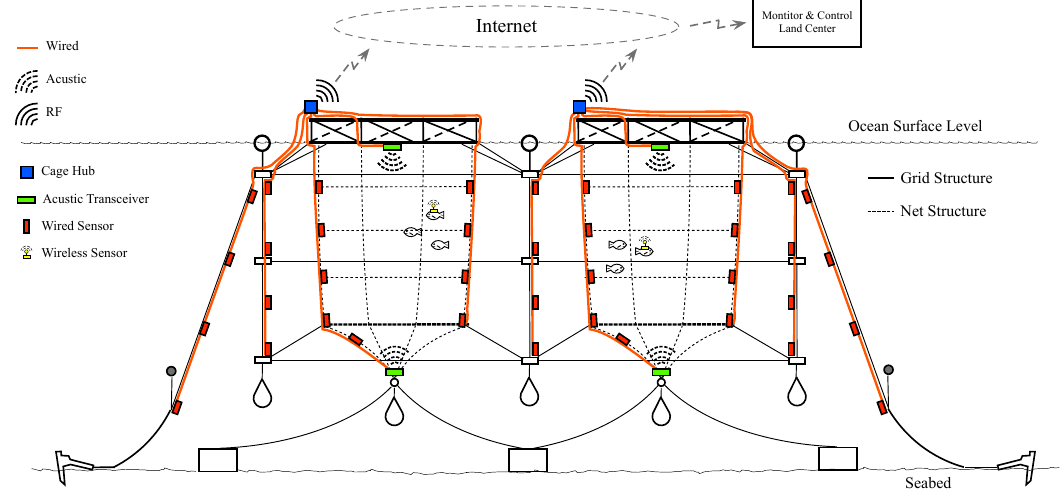
Figure 2. Mixed communication technologies applied to an offshore fish farm sensor network.